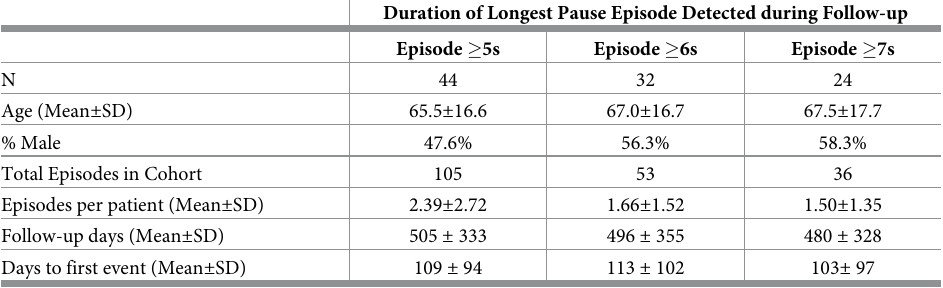
Abbreviations: SD, standard